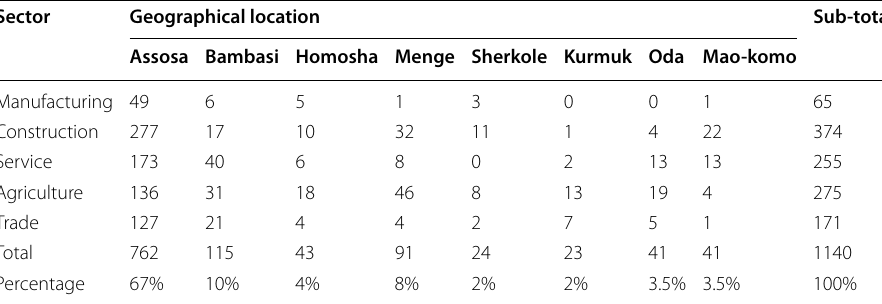
Table 1 Population distribution Sector